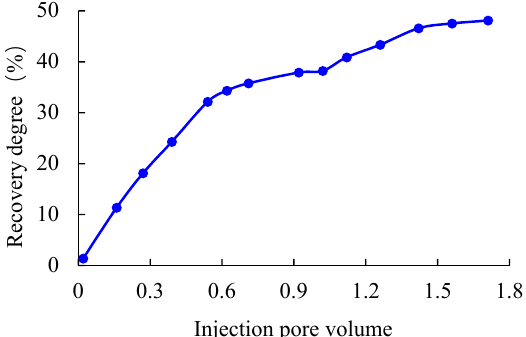
Figure 10. The relationship between injected pore volume and recovery degree of 0.45 mD core.